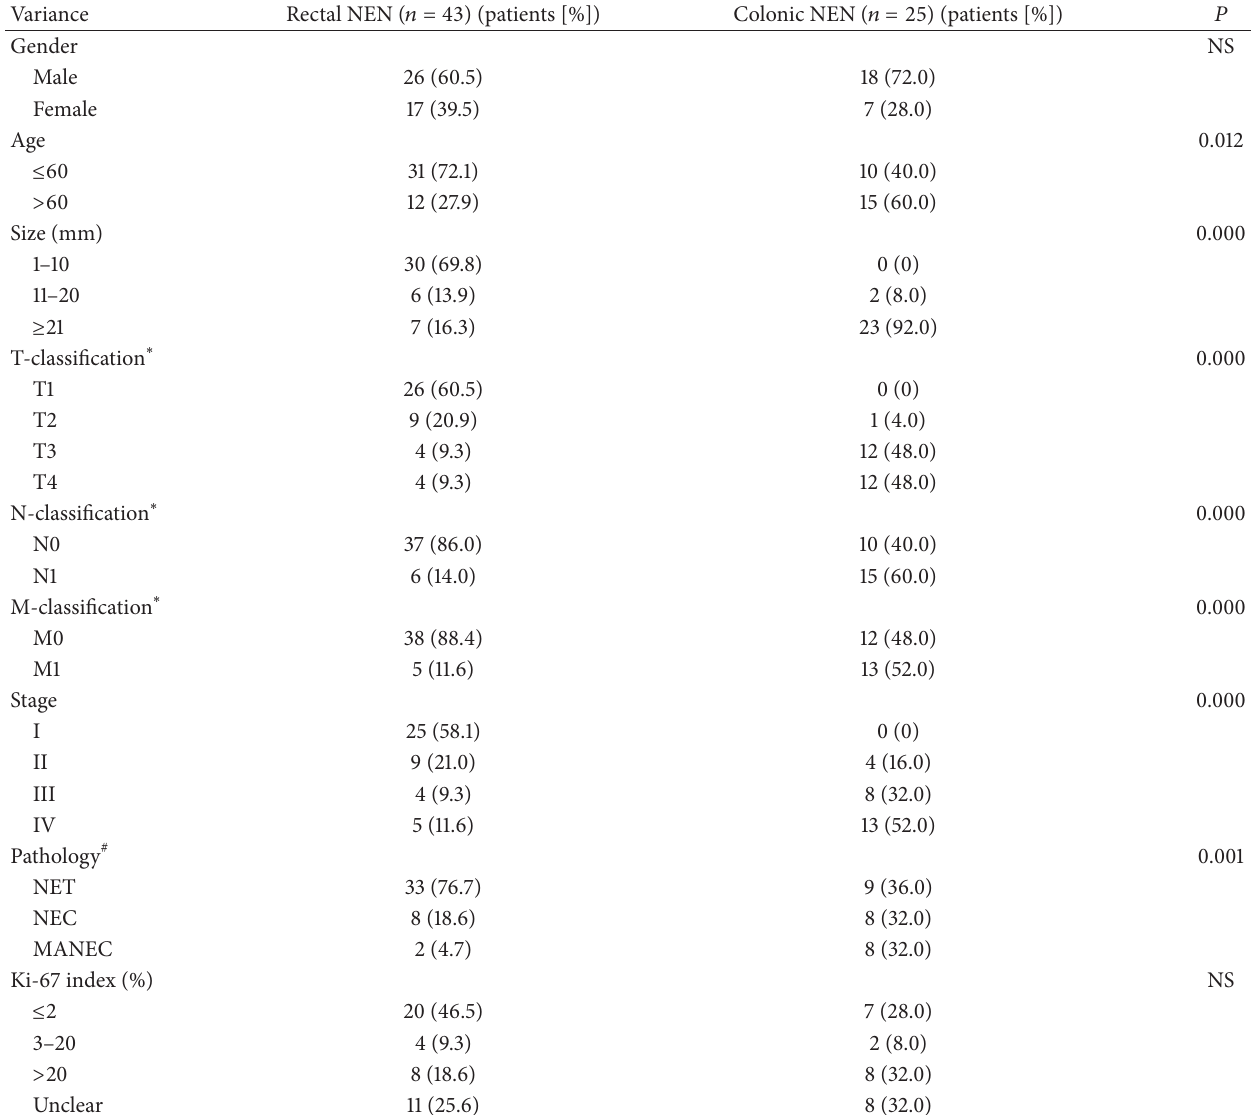
Table 1: The clinicopathological characteristics of 68 colorectal neuroendocrine neoplasm patients.